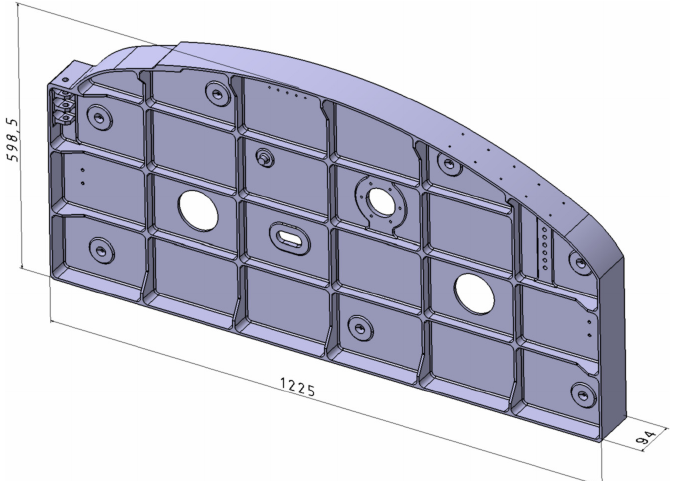
Figure 10. Virtual 3D-model, illustrating the outer dimensions of the MPQP test artefact.